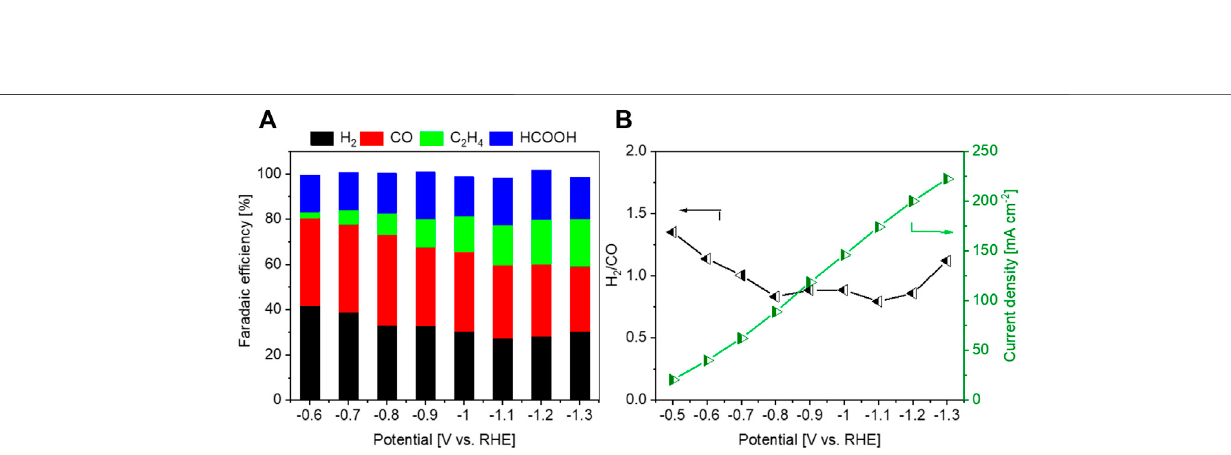
Frontiers in Chemistry |